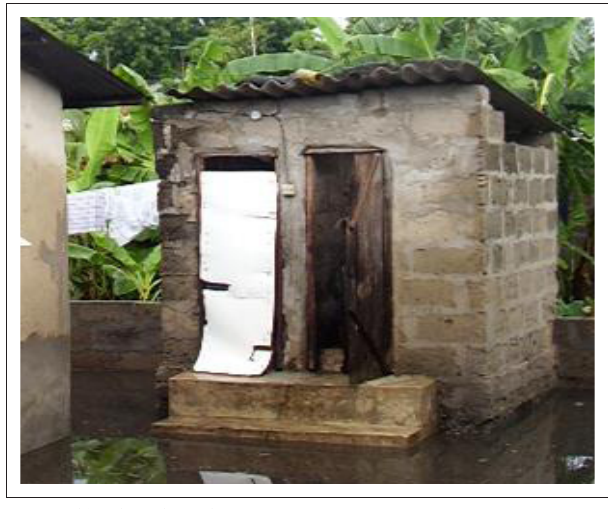
FIGURE 2: A pit latrine surrounded by stagnant water during rainfall